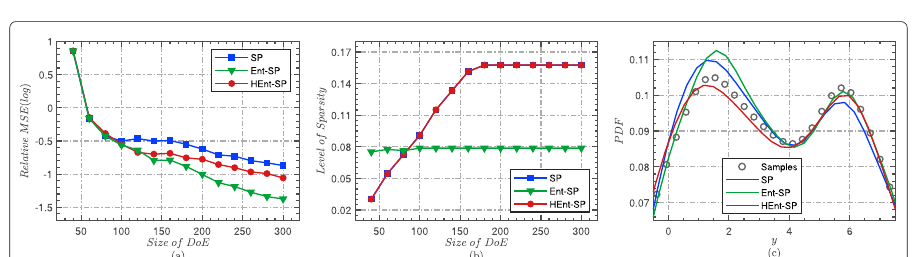
Fig. 4 Performance comparison of SP, Ent-SP and HEnt-SP w.r.t. the Ishigami model. ( a ) The relationship between the relative MSE and the size of DoE; ( b ) The relationship between the sparsity level of several methods and the size of DoE; ( c ) Enlarged details of the reconstructed PDF